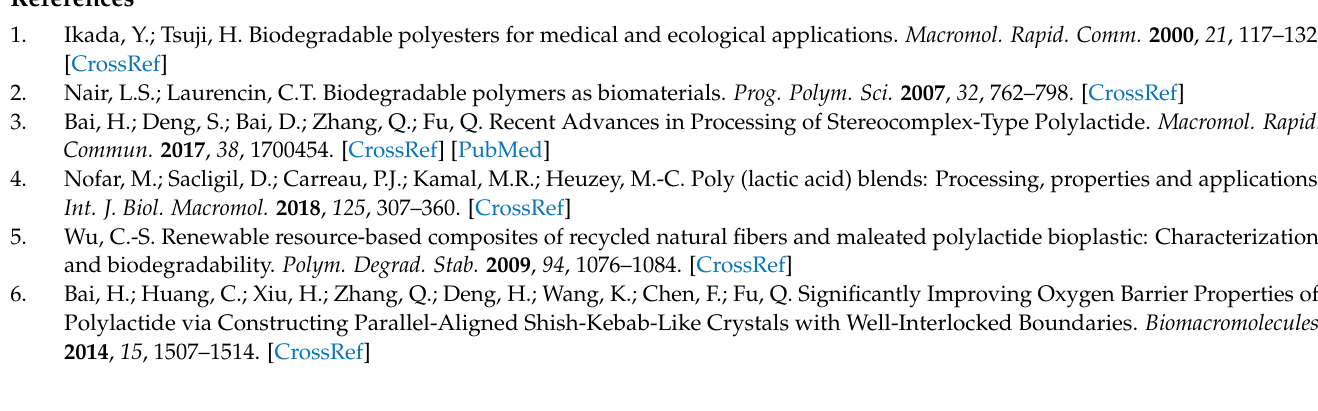
Figure S3: SEC traces of (a) PS-OH and (b) P2VP-OH in THF at 35 ◦ C; Figure S4: CD spectra of PS 6.2 - b-PDLA 5.5 , P2VP 5.5 -b-PLLA 5.6 , and SCPLA 5.5 were measured in acetonitrile with a concentration of 0.1 mg mL − 1 at room